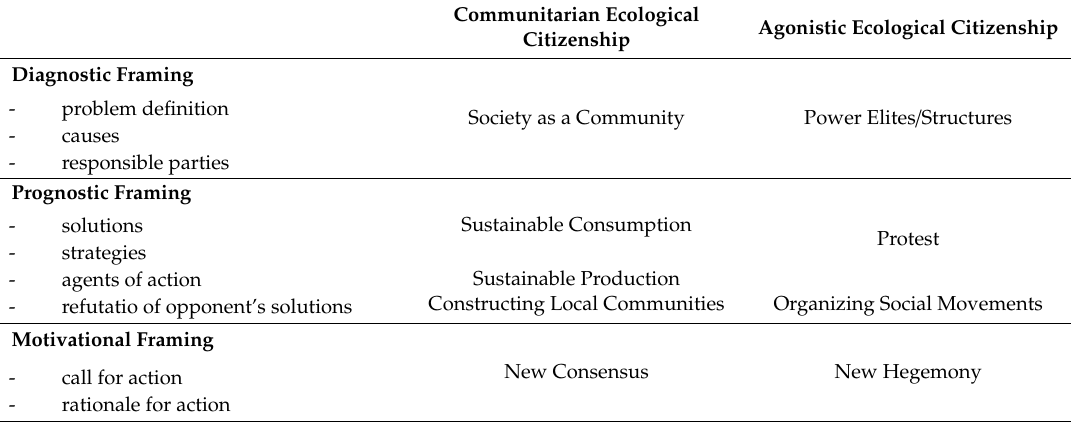
Table 1. Analytic Heuristic for Studying Ecological Citizenship with a Movie